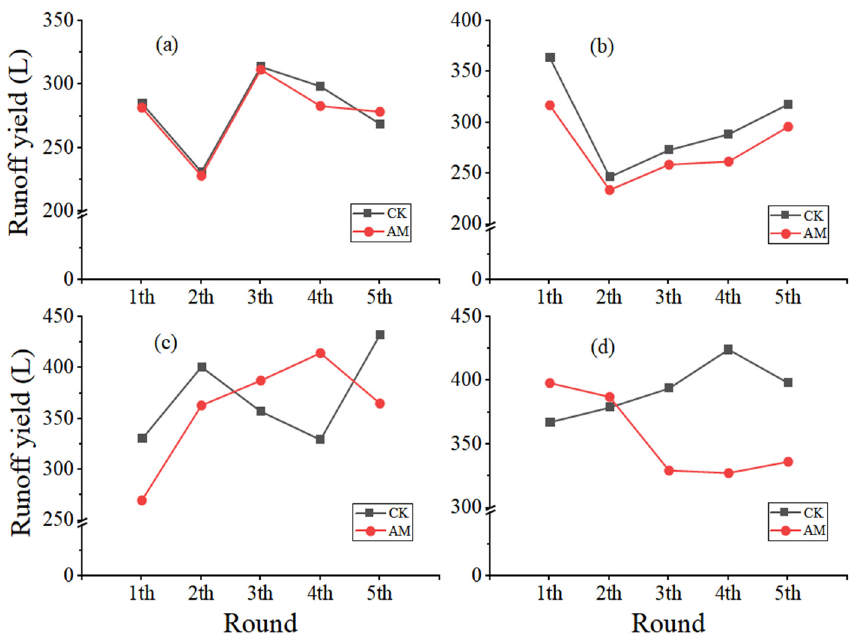
Figure 1. Variation in runoff yield in different soil troughs under simulated scouring in ( a ) Cynodon dactylon , ( b ) Lotus corniculatus , ( c ) Zoysia japonica , and ( d ) Astragalus sinicus .